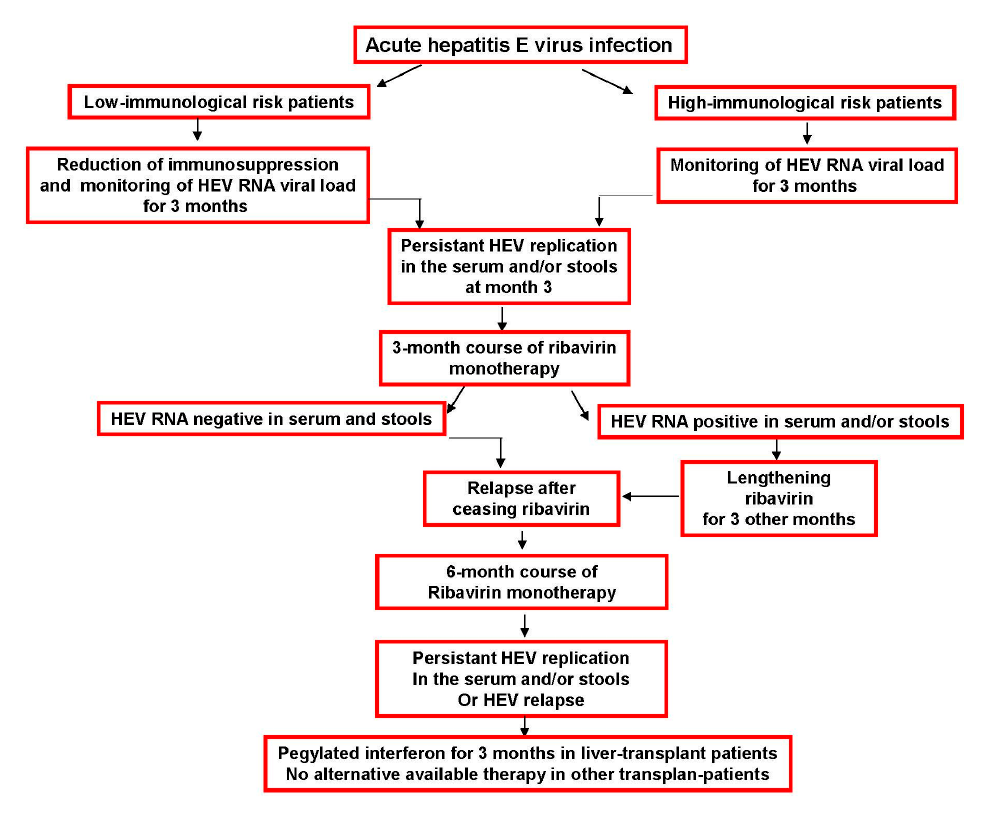
Figure 1. Treatment of hepatitis E virus persistent infection in solid-organ-transplant